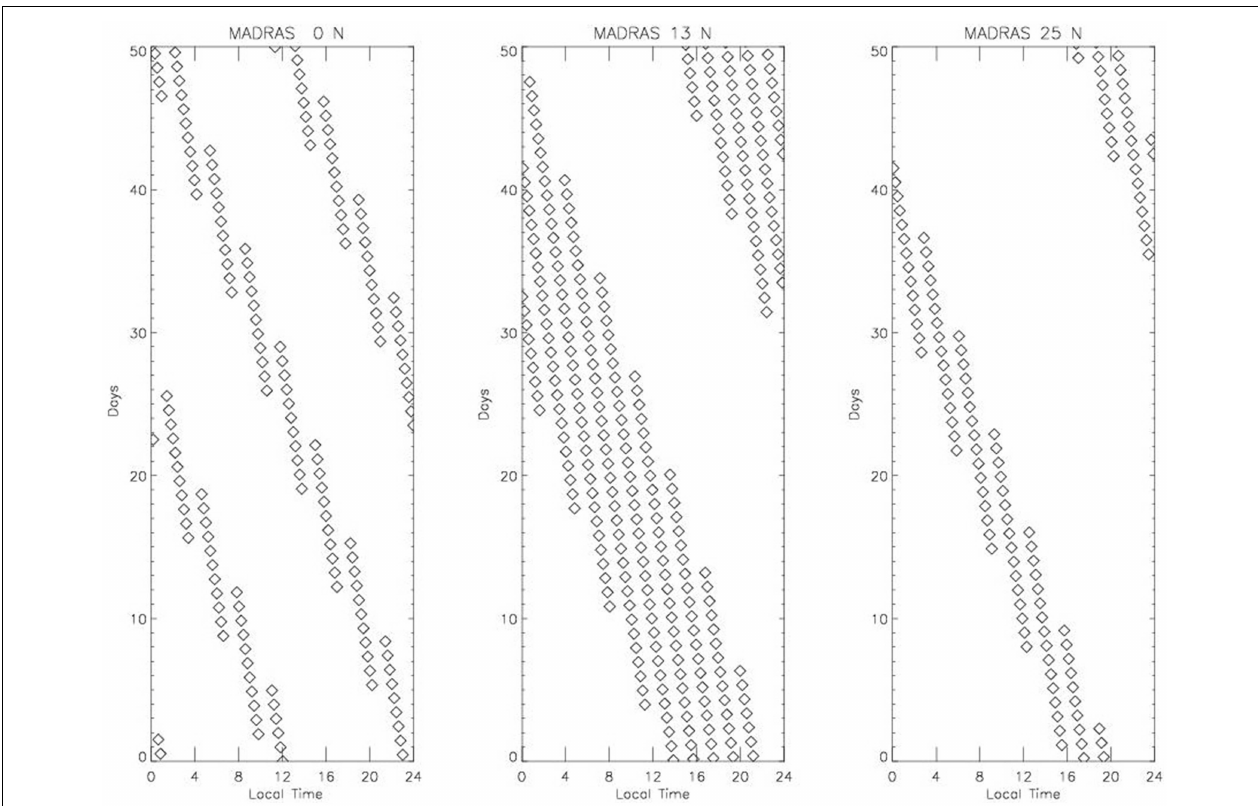
FIGURE 2 | 51 days of local time sampling for the MADRAS instrument on-board MT for the Equator (left), a 13 ◦ N position (center) and 25 ◦ N position (right). Diamonds correspond to overpasses.